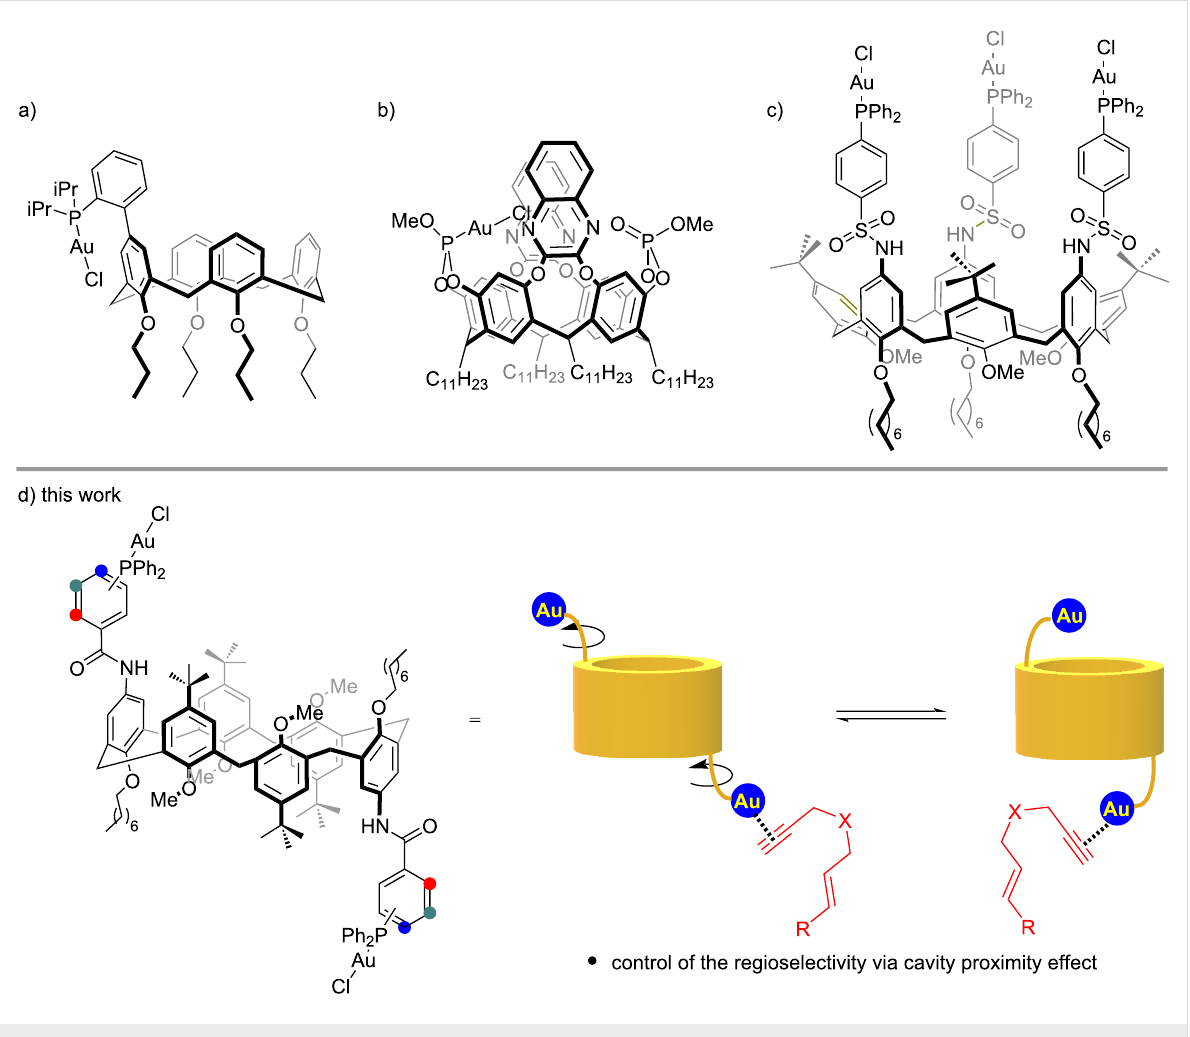
Figure 1: Selected examples of: a) calix[4]arene-; b) resorcin[4]arene-; c) calix[6]arene-gold(I) macrocyclic catalysts. d) Working hypothesis for novel calix[6]arene phosphine